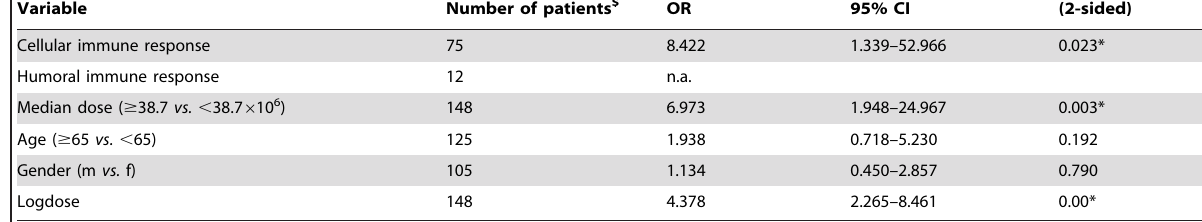
Prostate cancer